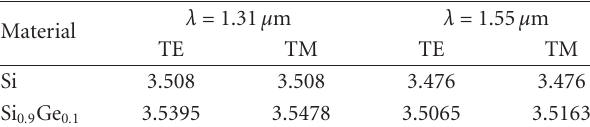
Table 1: Refractive index of Si 0 . 9 Ge 0 . 1 and Si materials for TE and TM modes of λ = 1 . 31 μ m and 1.55 μ m.